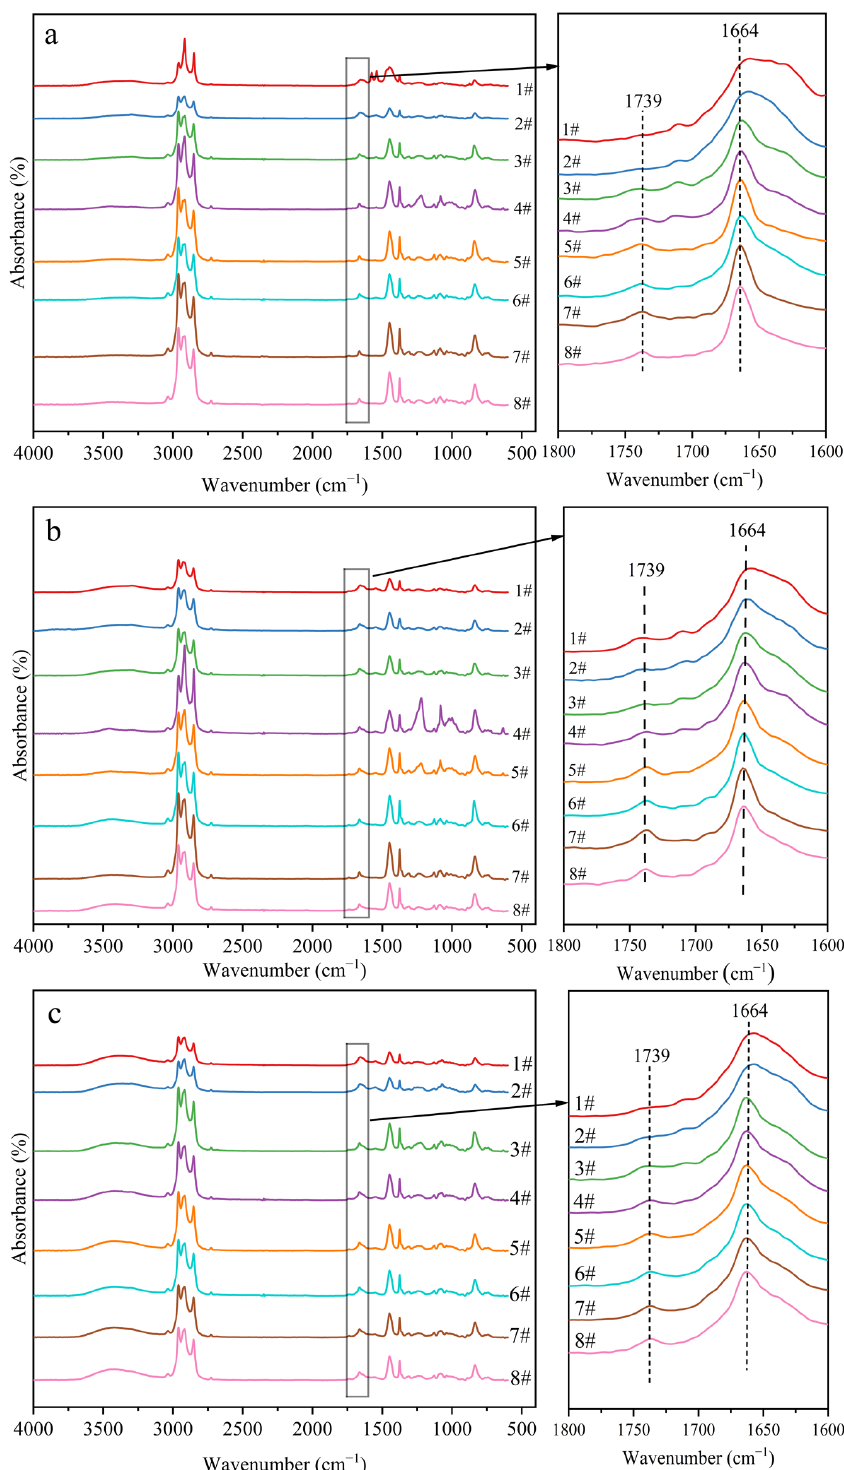
Figure 7. FTIR spectra of rubber films obtained from separated latexes from different Hevea brasiliensis clones: ( a ) IAN873; ( b ) Dongfang93114; ( c ) Reyan73397.